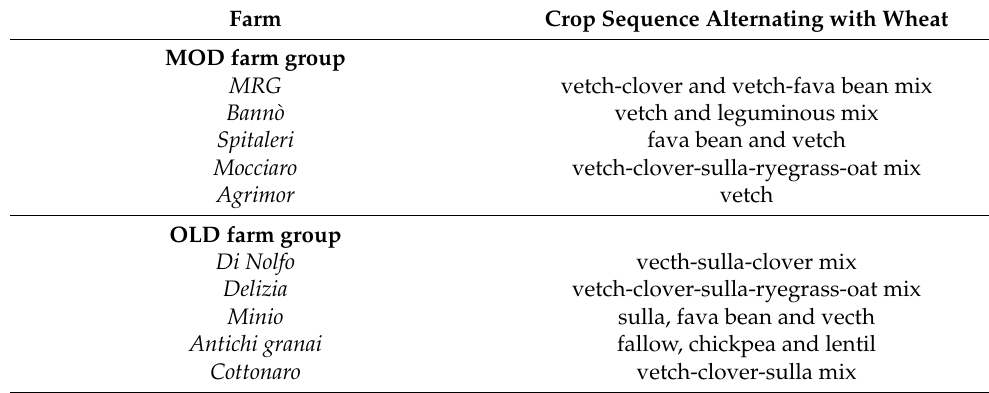
Table 8. Crop sequence of the ten farms under study over the last ten